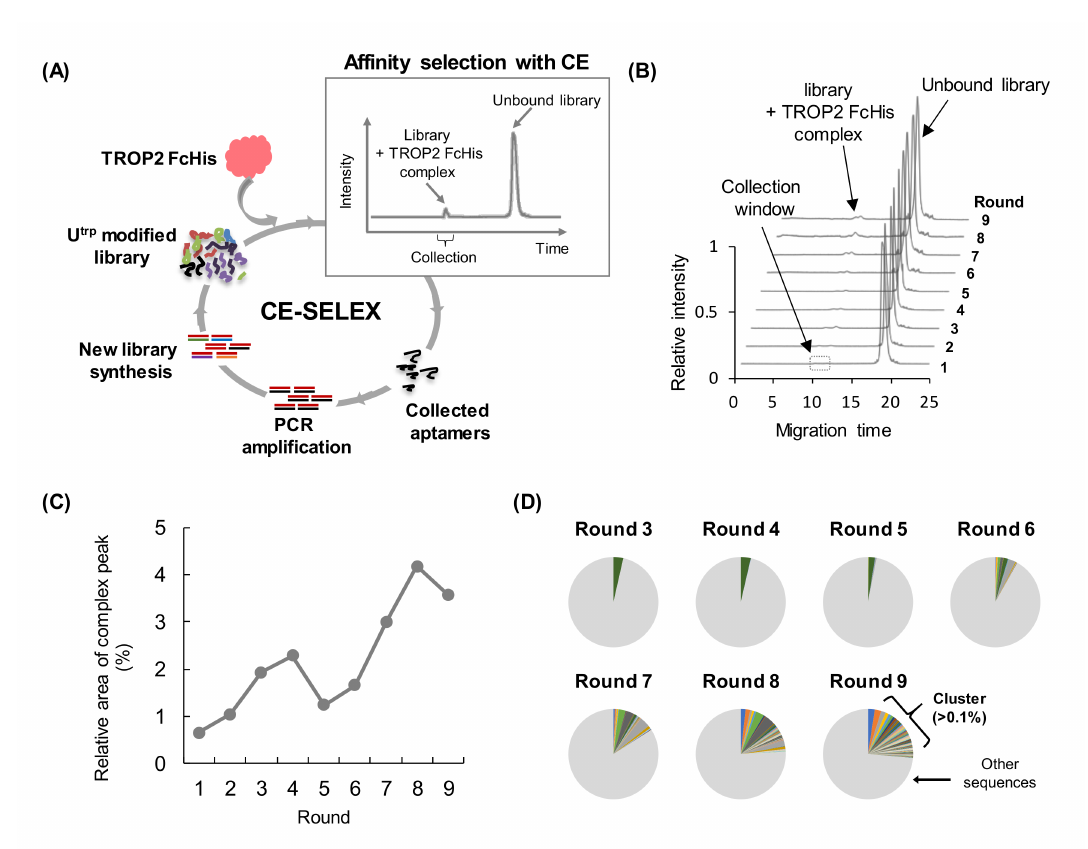
Figure 2. Selection of TROP2 binding aptamers using CE-SELEX. ( A ) CE-SELEX scheme for the selection of U trp modified aptamers that can bind to the recombinant TROP2 FcHis protein. ( B ) Electropherograms were obtained from rounds 1 to 9 in the separation step. The target-binding species were collected during the collection window, indicated as a dotted line box, and amplified for the next round of selection. ( C ) Ratio of the complex peak to the unbound library peak in each round is shown. ( D ) Degree of sequence enrichment after two rounds of CE-SELEX. Clusters with more than 0.1% of the sequences in each round are visualized in colors, and all clusters with less than 0.1% of sequences are marked as other sequences (gray). Rounds 1 and 2 were omitted due to low clustering